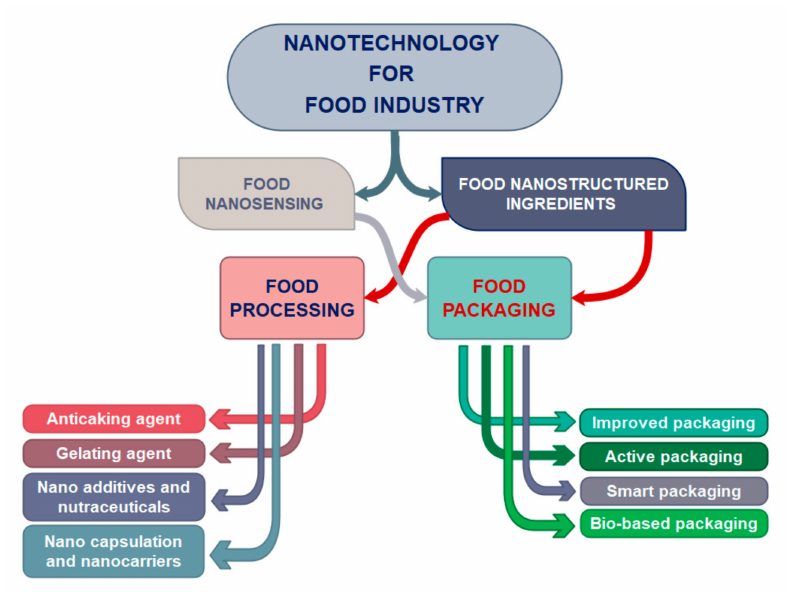
Figure 1. Application of (bio)nanotechnology in different fields of the food